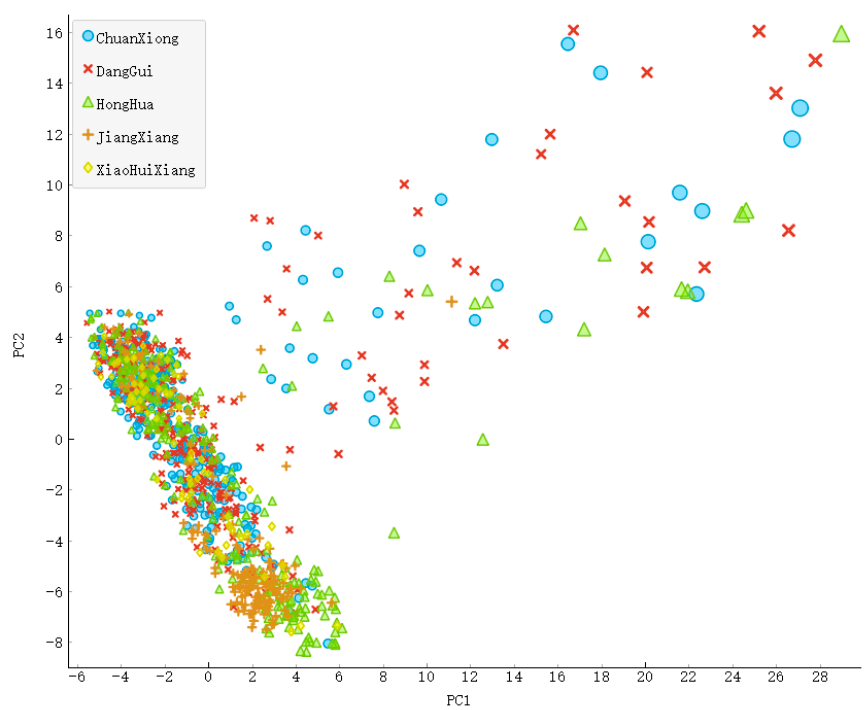
Figure 8. Five pungent TCMs’ compounds PCA with Fingerprint of 166 bits.